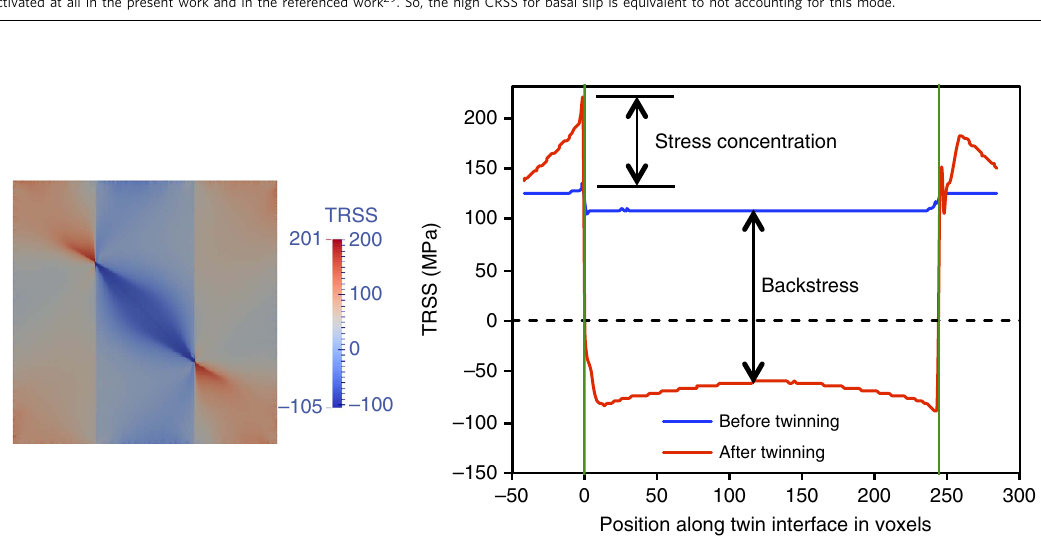
Figure 5 | Distribution of twinning shear-induced TRSS field. TRSS field after twinning and the TRSS profile along twin boundary before and after twinning in Zr for the neighbour orientation (0 (cid:2) , 30 (cid:2) , 0 (cid:2) ). The stress concentration ahead of twin tip is marked. The twin tip/grain boundary junctions are marked by two vertical green